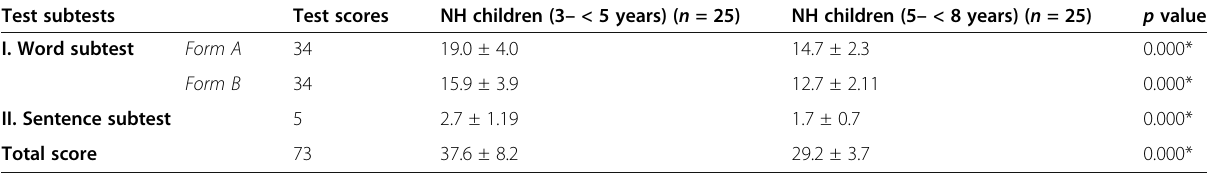
Values are means (SD) *Paired t test; p value at < 0.05 indicates